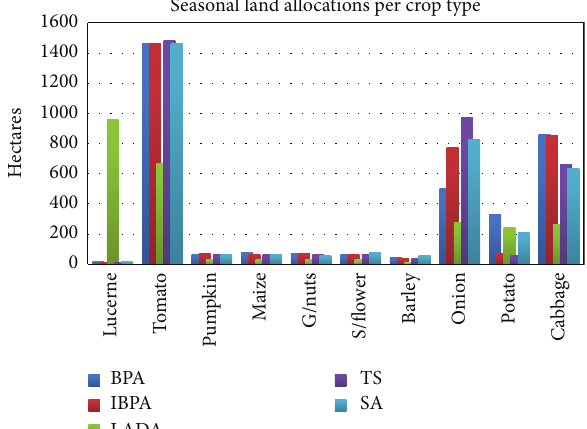
Figure 7: A comparison of the hectare allocations, per crop, for the best solution found by each heuristic